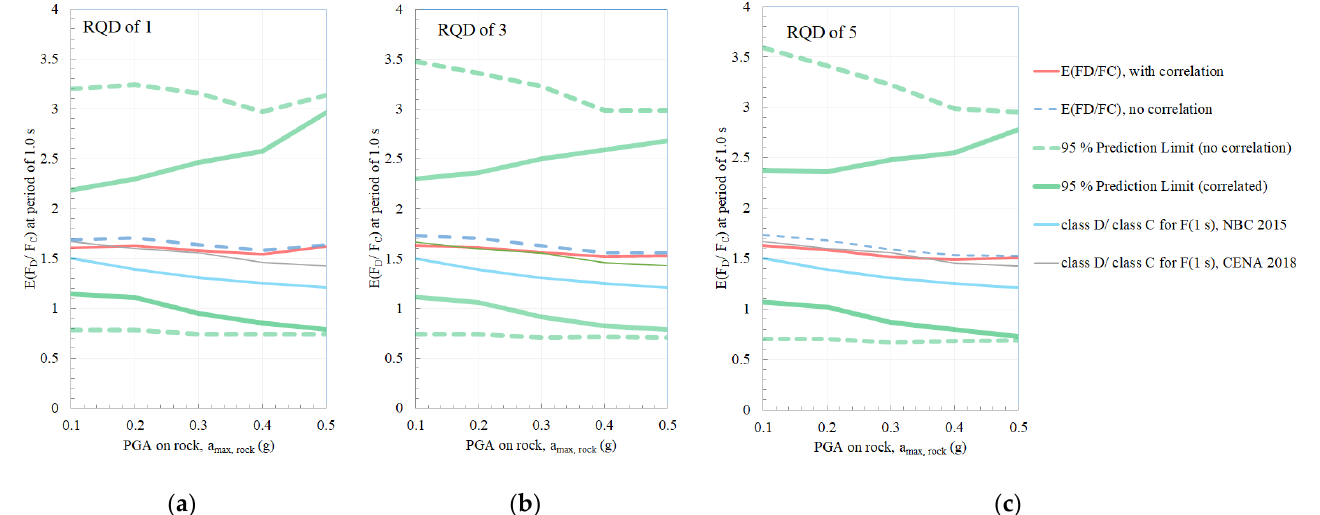
Figure 21. Comparison between (F D /F C ) at T = 1.0 s and the site factors in NBCC (2015) and the CENA site factors published by Hashash et al. [11] for RQD of 1 ( a ), 3 ( b ) and 5 ( c ).